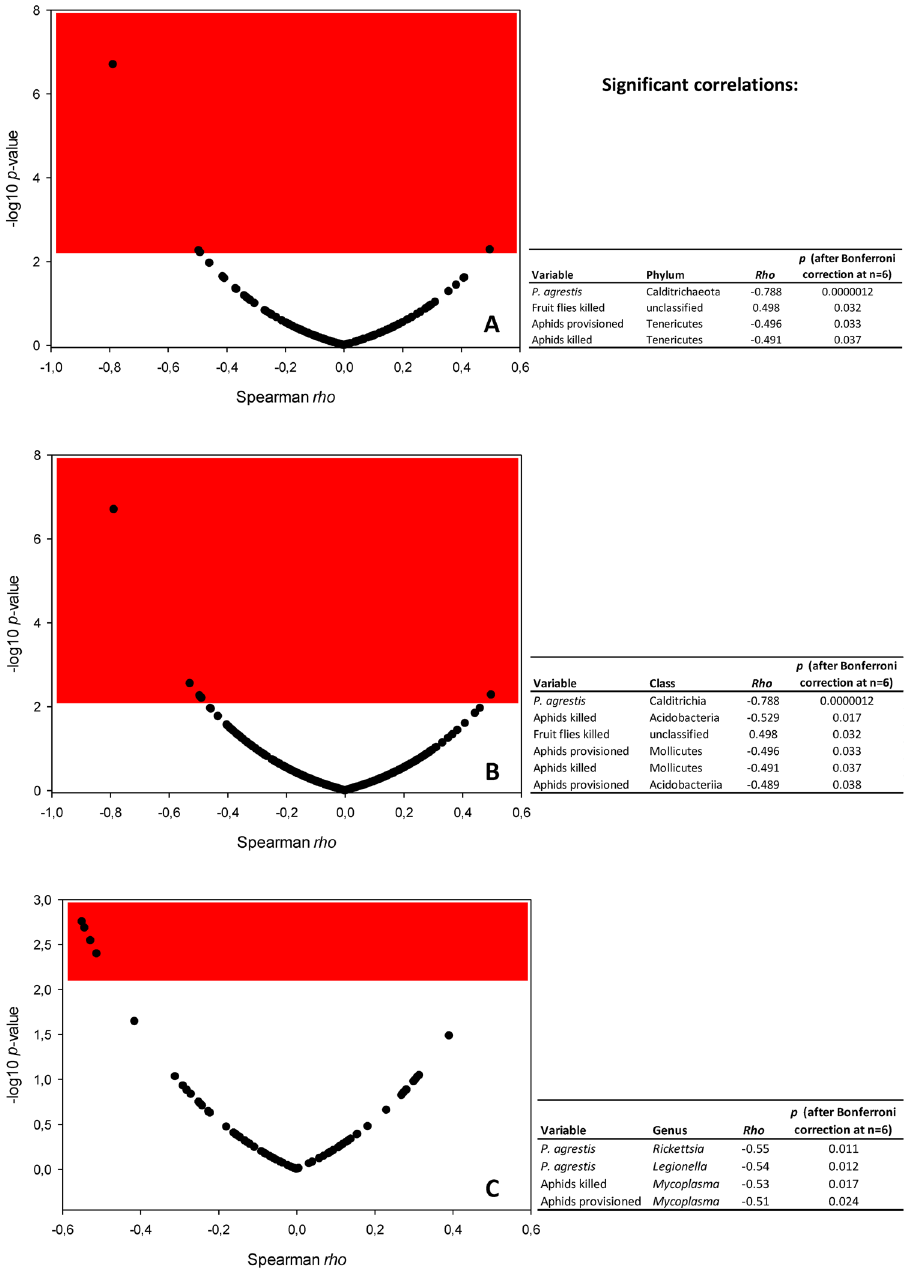
Figure 2. Volcano plots for Spearman correlations between the environmental variables (provisioned food, frequency of any provisioned food, P. agrestis / P. palustris , number of provisioned aphids, number of provisioned fruit flies, number of killed aphids, number of killed fruit flies, traveled distance) and bacterial and archaeal phyla ( A ), classes ( B ), or selected genera of obligate or facultative endosymbionts ( C ). The lists of tested bacterial and archaeal classes, bacterial and archaeal phyla, and genera of endosymbionts are provided in Tables S2, S1, and S3, respectively. The red area indicates significant correlations (− log p < 0.05 after applying Bonferroni correction at n = 6). Significant variables ( p < 0.05 after applying Bonferroni correction at n = 6) are shown in tables accompanying each